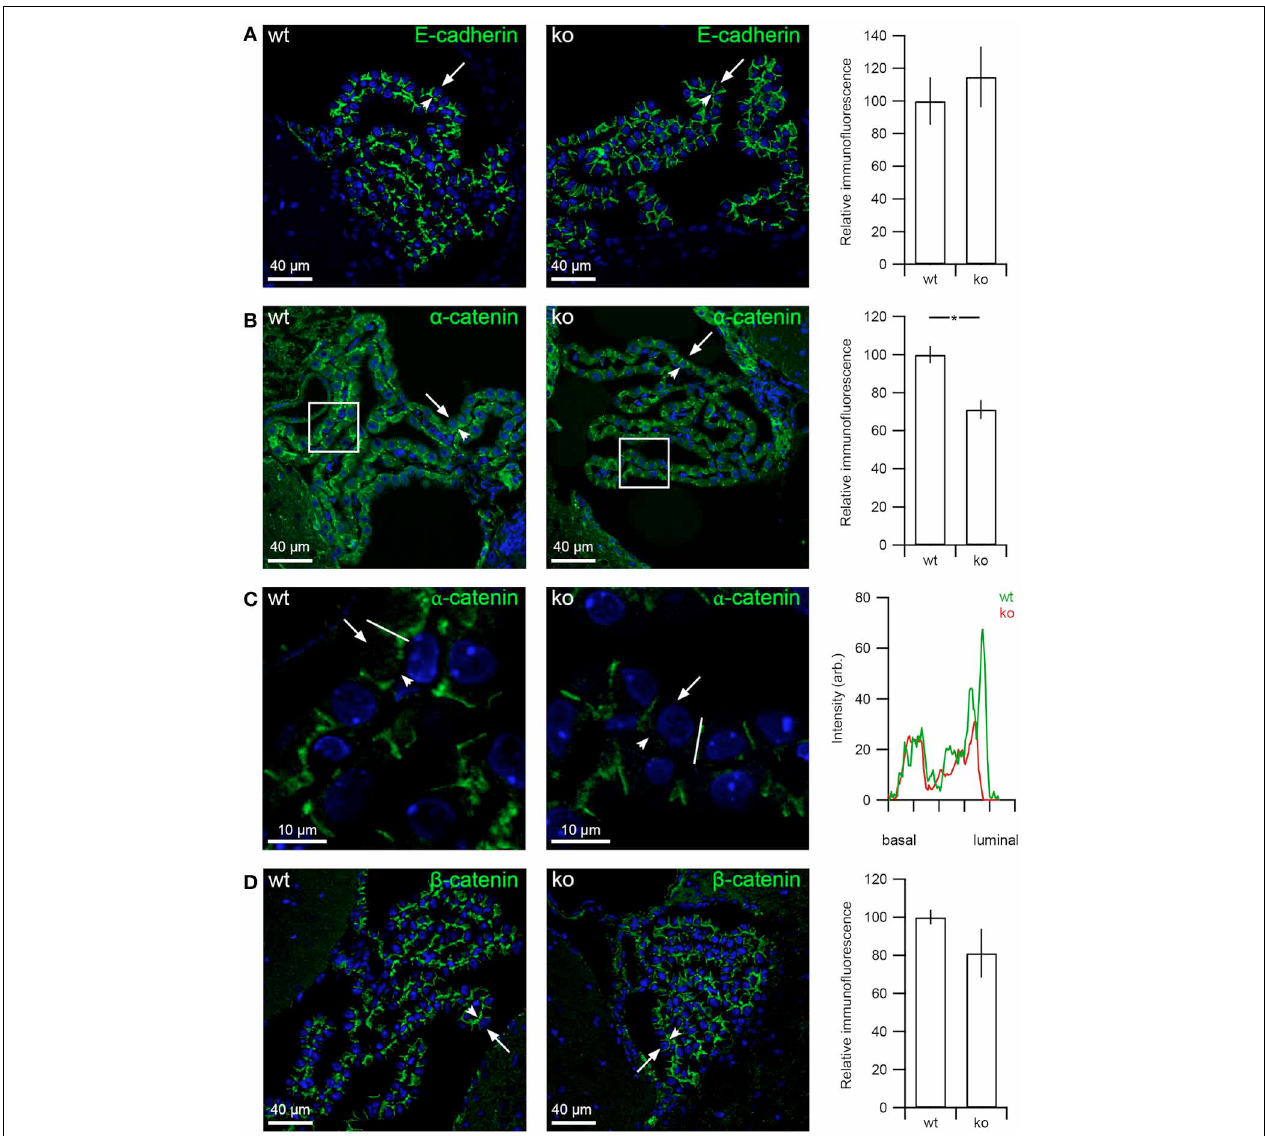
FIGURE 9 | E-cadherin, α -and β -cateninexpressioninCPEfrom slc4a10 wt and komice. Mouse brainsections were immunostained for E-cadherin and α - and β -catenin, as indicated. (A) Immunohistochemical detection of E-cadherin in slc4a10 wt and ko, as indicated. Bar graphs on the right show the semi-quantitationoftheimmunofluorescencein slc4a10 wtandkomouseCPE ( n = 4). (B) Immunolabelingfor α -cateninin slc4a10 wtandko,asindicated.Bar graph on the right show the semi-quantitation of the immunofluorescence in slc4a10 wt and ko mouse CPE (wt: n = 5, ko: n = 3). (C) High magnification